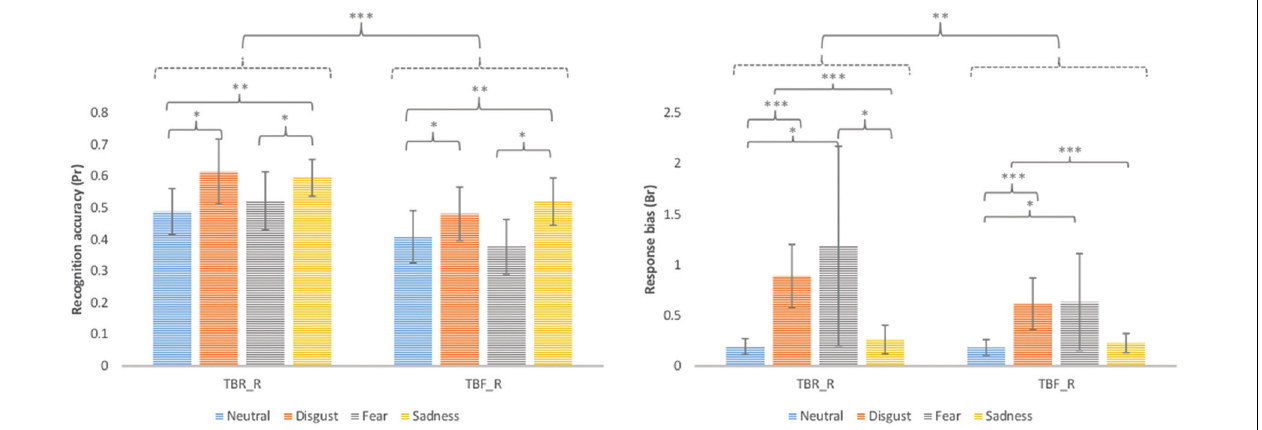
FIGURE 2 | False alarm corrected recognition accuracy (Pr) and response bias (Br) for correctly recognized TBR and TBF images (TBR_R and TBF_R, respectively). Error bars represent standard deviation. ∗ p < 0.05; ∗∗ p < 0.01; ∗∗∗ p < 0.001.